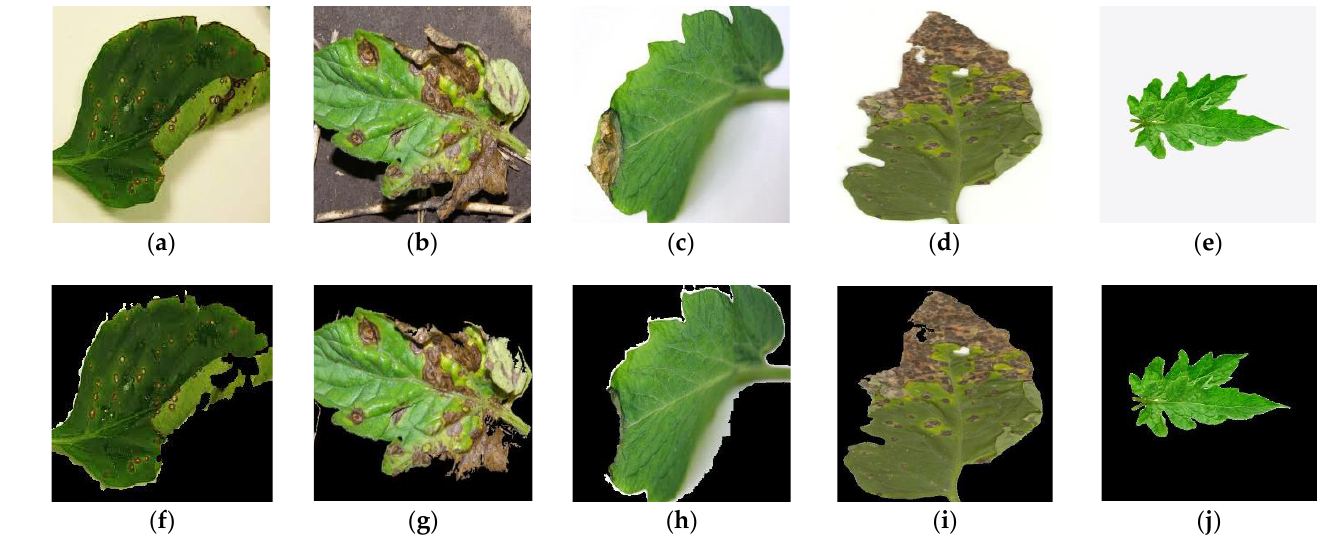
Figure 8. Five segmented field tomato leaf images: ( a ) The field images of bacterial spot disease; ( b ) Early blight disease; ( c ) Late blight disease; ( d ) Septoria leaf spot disease; ( e ) Healthy leaf; the segmented field images of ( f ) Bacterial spot disease; ( g ) Early blight disease; ( h ) Late blight disease; ( i ) Septoria leaf spot disease; ( j ) Healthy leaf.